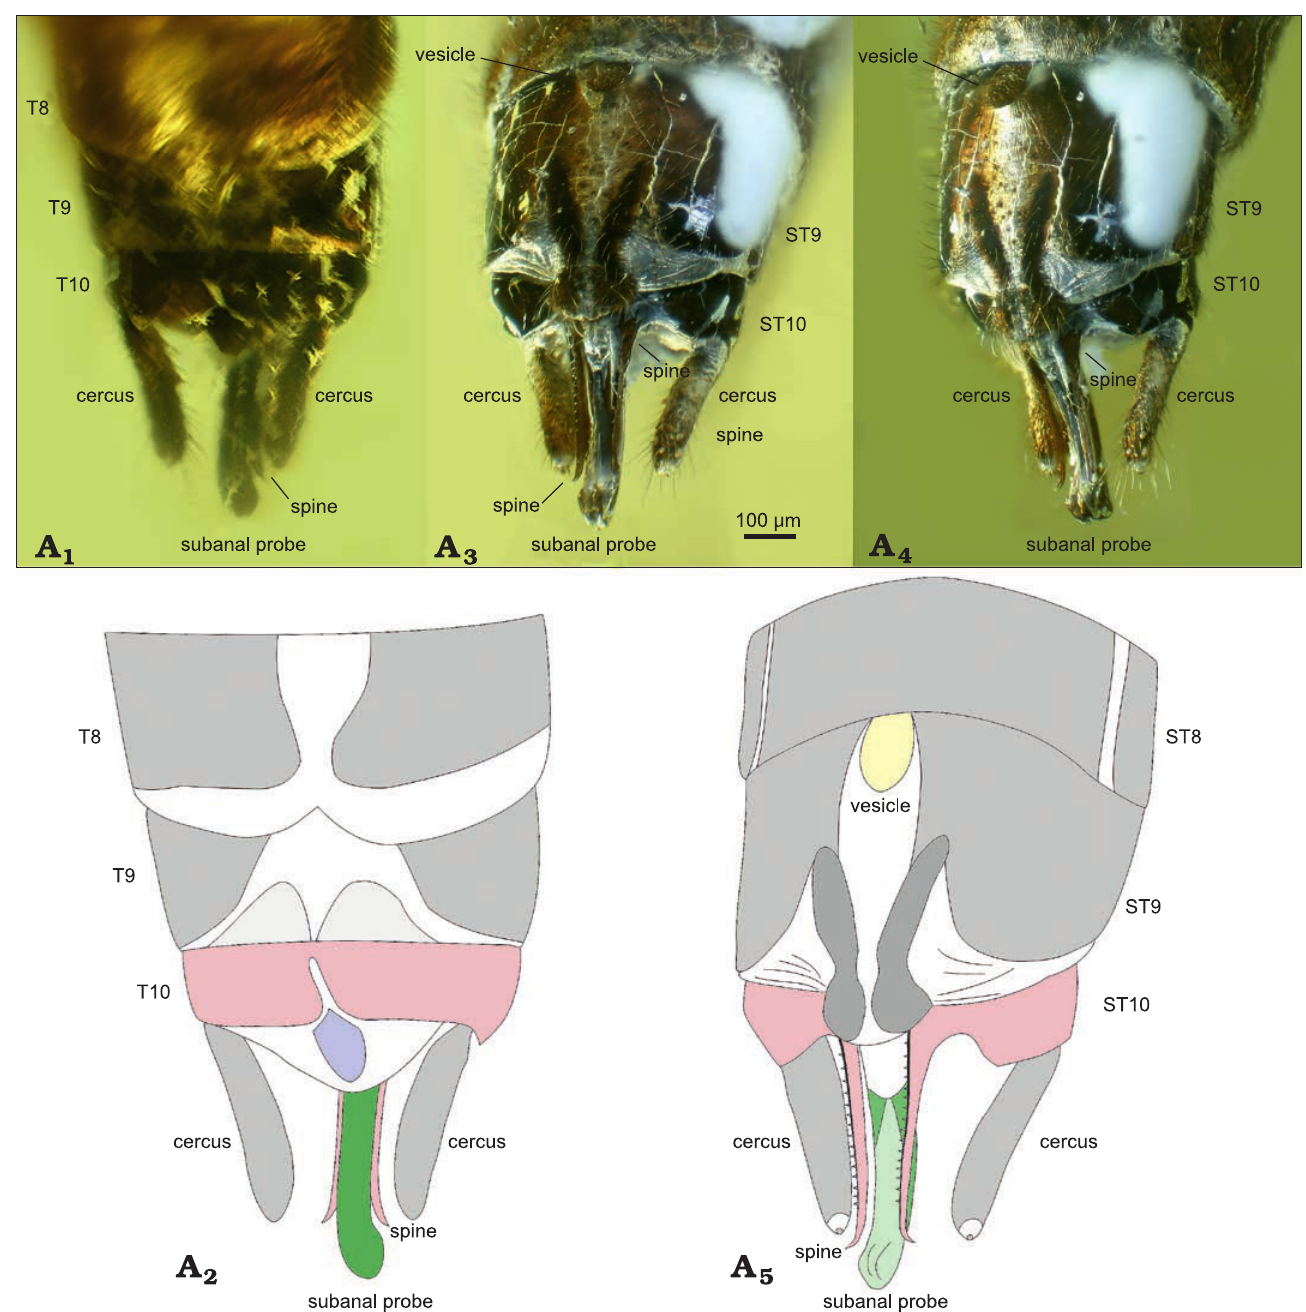
Fig. 3. Needle stonefly Baltileuctra dewalti Chen sp. nov. (holotype, ICJUST CZT-PLE-BA8) from Eocene Baltic Amber from unknown locality in Lithuania. Male adult terminalia in dorsal view (A